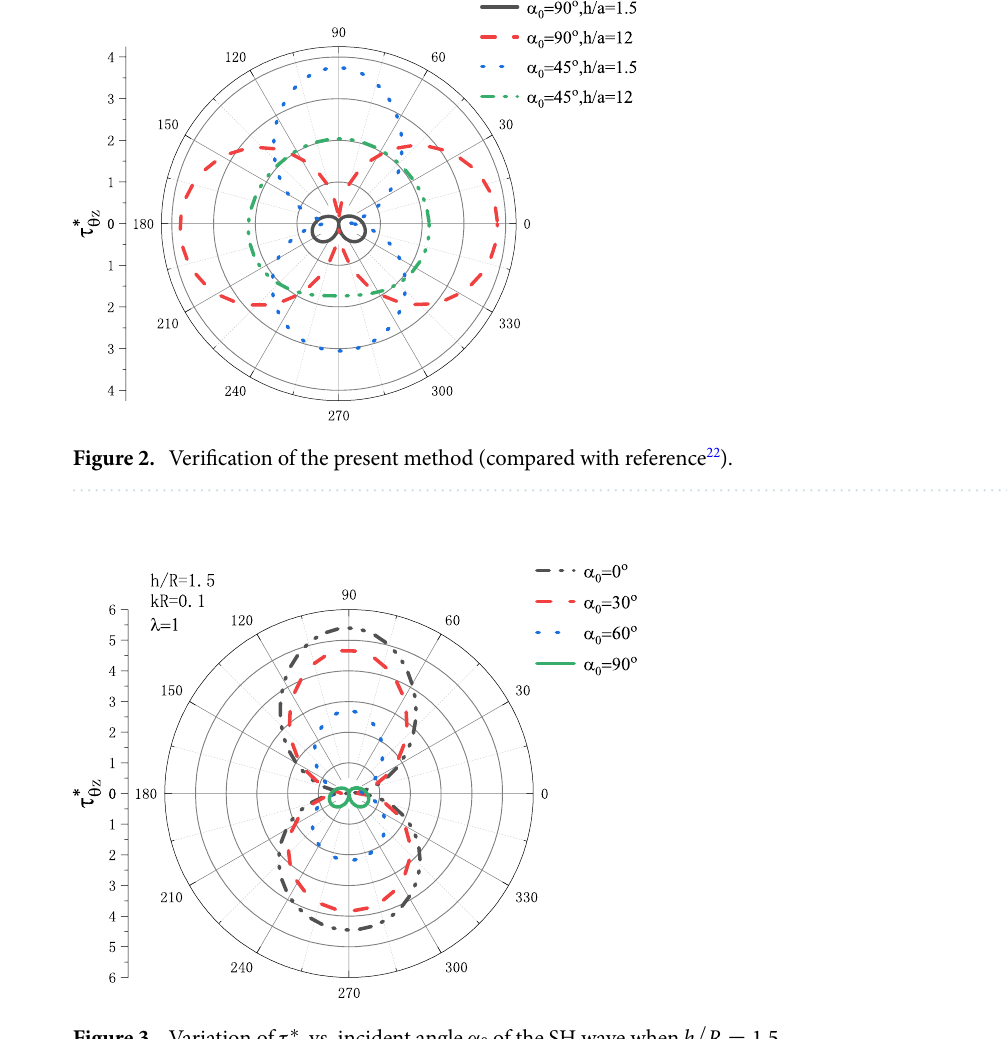
Figure 3. Variation of τ ∗ θ z vs. incident angle α 0 of the SH wave when h